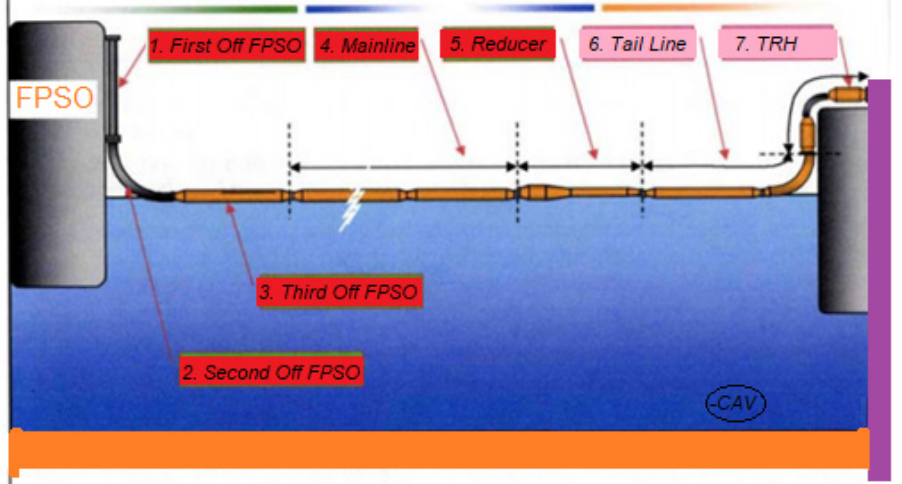
Figure 23. Hose array on a tandem hose system, showing 7 different types of hoses utilized on a classical FPSO tandem terminal, namely: ( a ) First off FPSO, ( b ) Second off FPSO, ( c ) Third off Buoy, ( d ) Mainline, ( e ) Reducer, ( f ) Tail line, and ( g ) Tanker Reeling Hose (TRH).